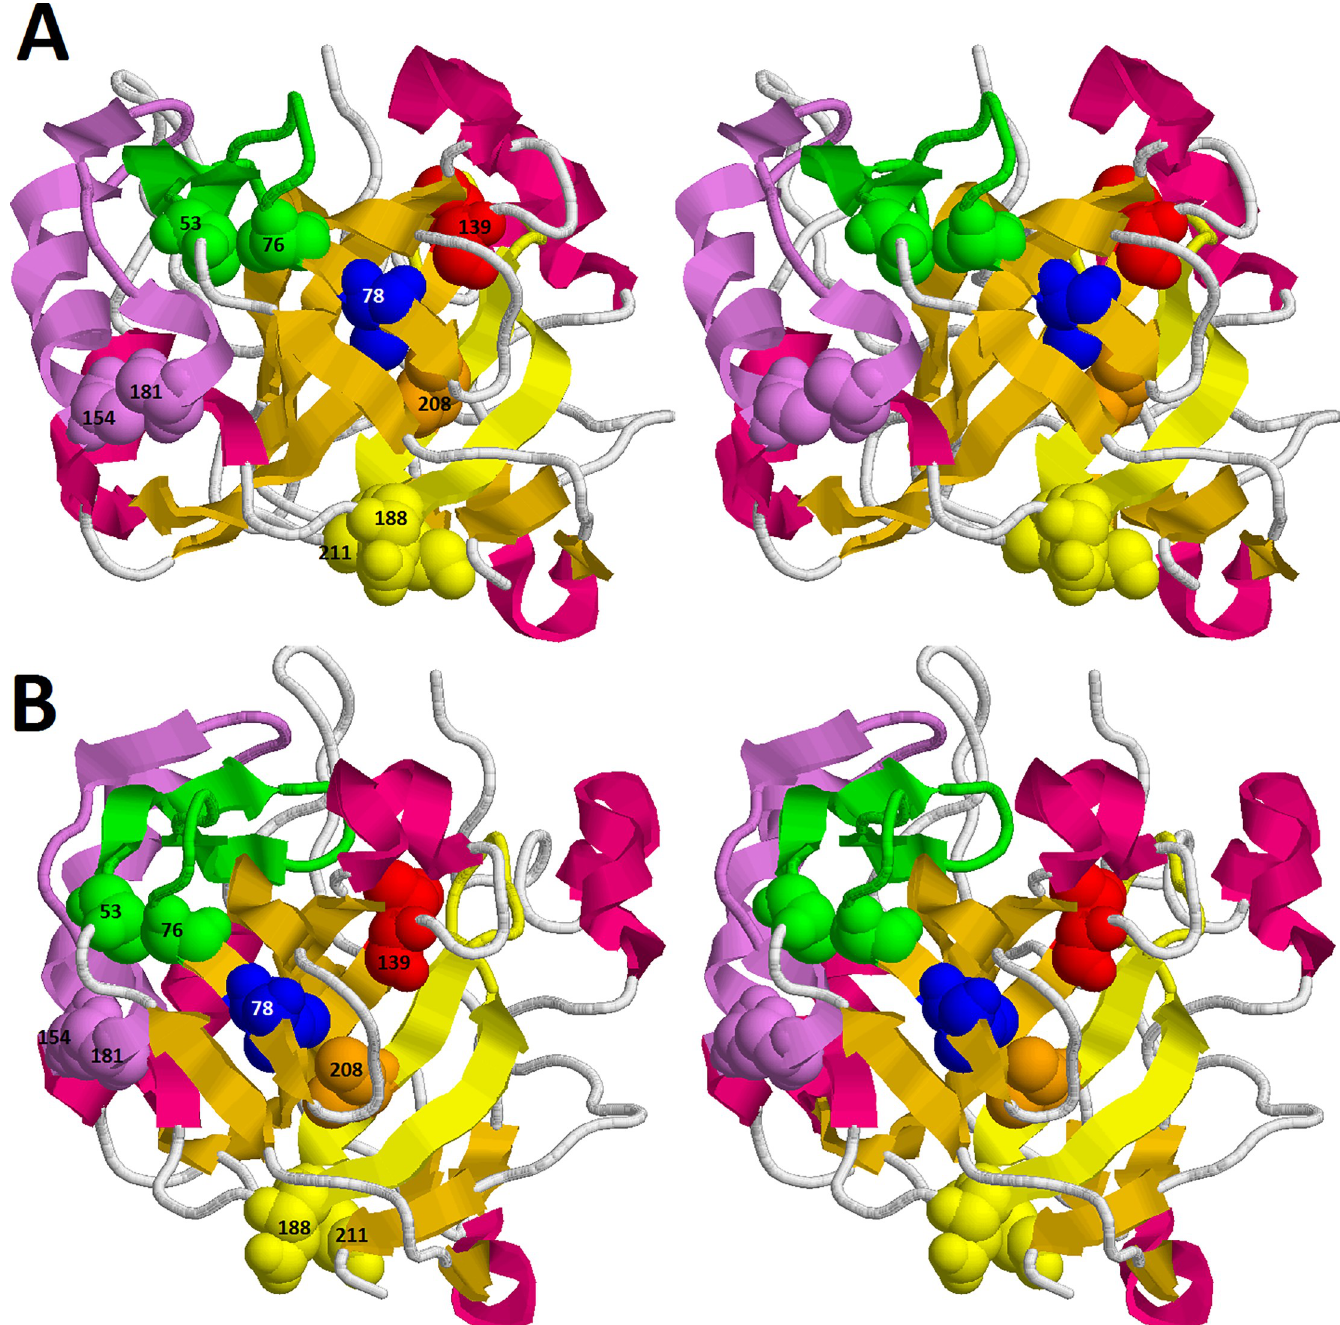
Fig 5. Three-dimensional structure of BCA II. (A) and (B) stereo view differ in the small turn of protein allowing to analyze the position of substituted amino acids (balls denoted). Three structure elements, αβ -hairpin and two β -hairpins, were cross-linked in A53C-A76C, A154C-S181C and D188C-K211C mutant forms by disulfide bridges colored green, purple and yellow correspondingly. Numbers of the substituted amino acids are